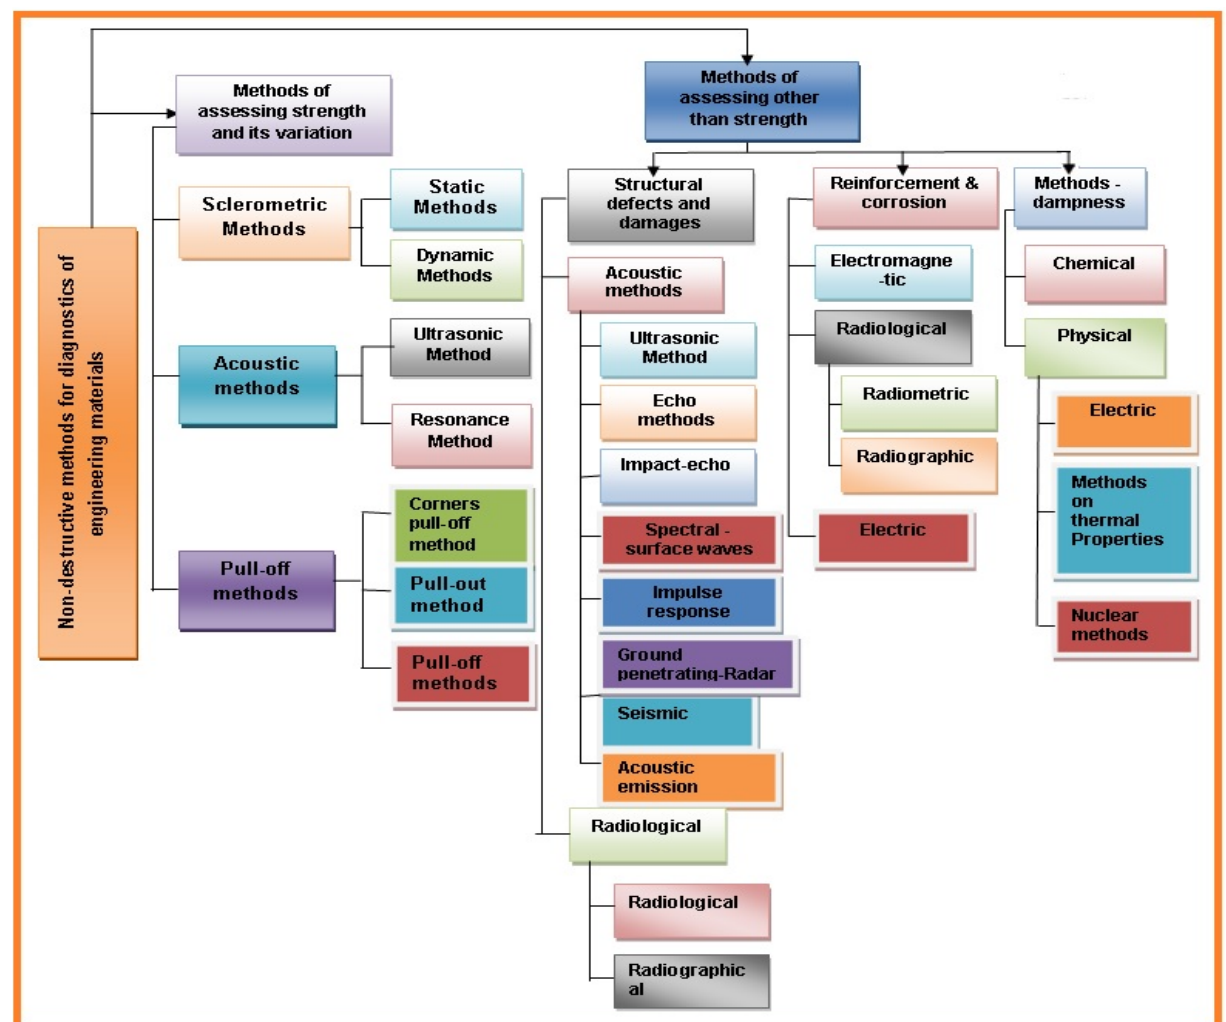
Figure 5. Nondestructive methods used for analysis of engineering material structures.